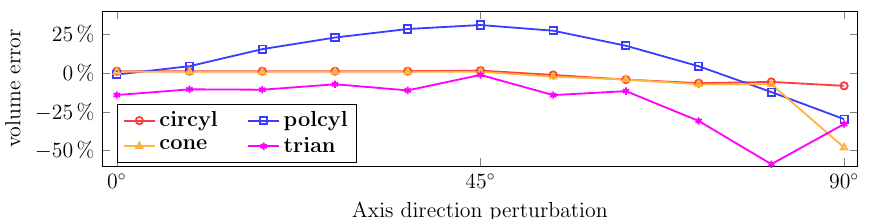
Figure 5. Relative volume error as a function of axis direction estimate perturbation.